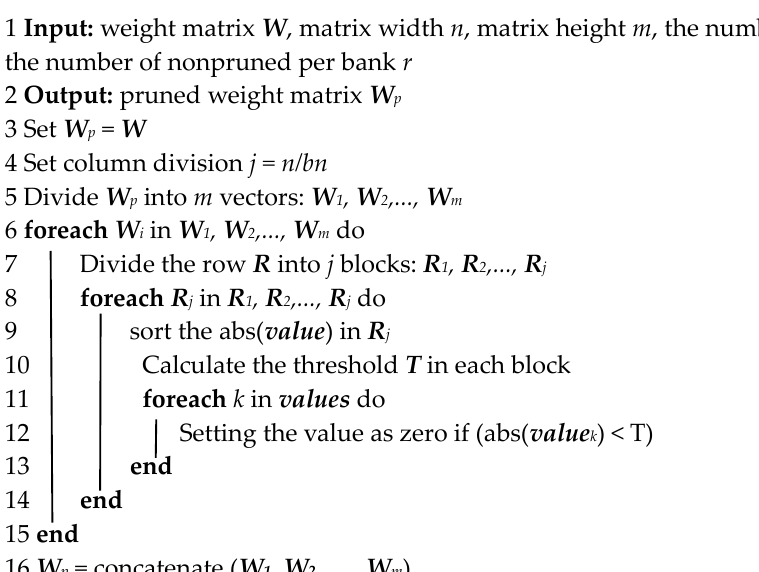
Algorithm 1: Bank-balanced weight pruning algorithm